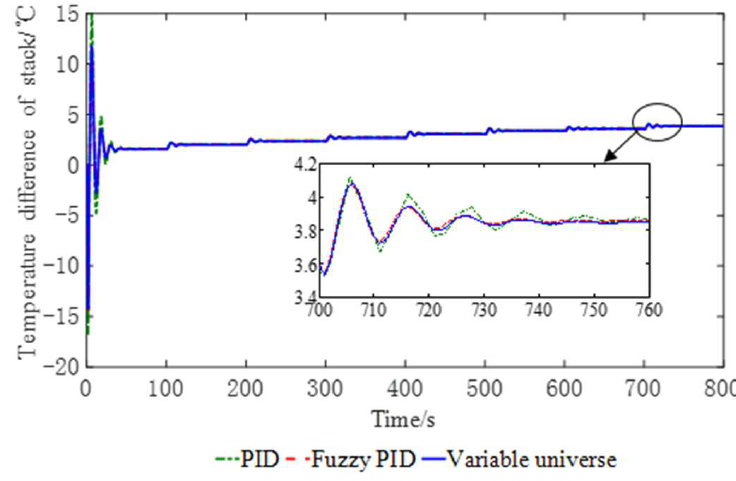
Figure 11. Temperature difference between inlet and outlet of coolant.